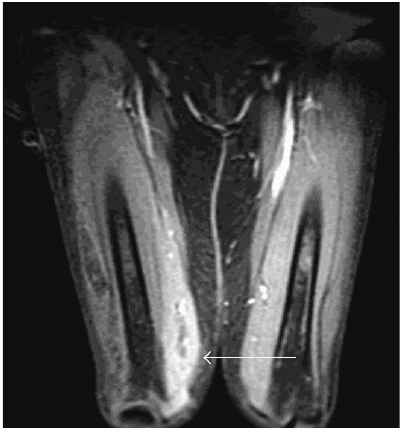
Figure 2: Coronal T2-weighted FAT SAT showing diffuse muscle edema involving the lower two-thirds of the anterior compartment muscles. The left thigh also shows muscle edema especially along the superior aspect of the rectus femoris and inferior aspect of the posterior compartment